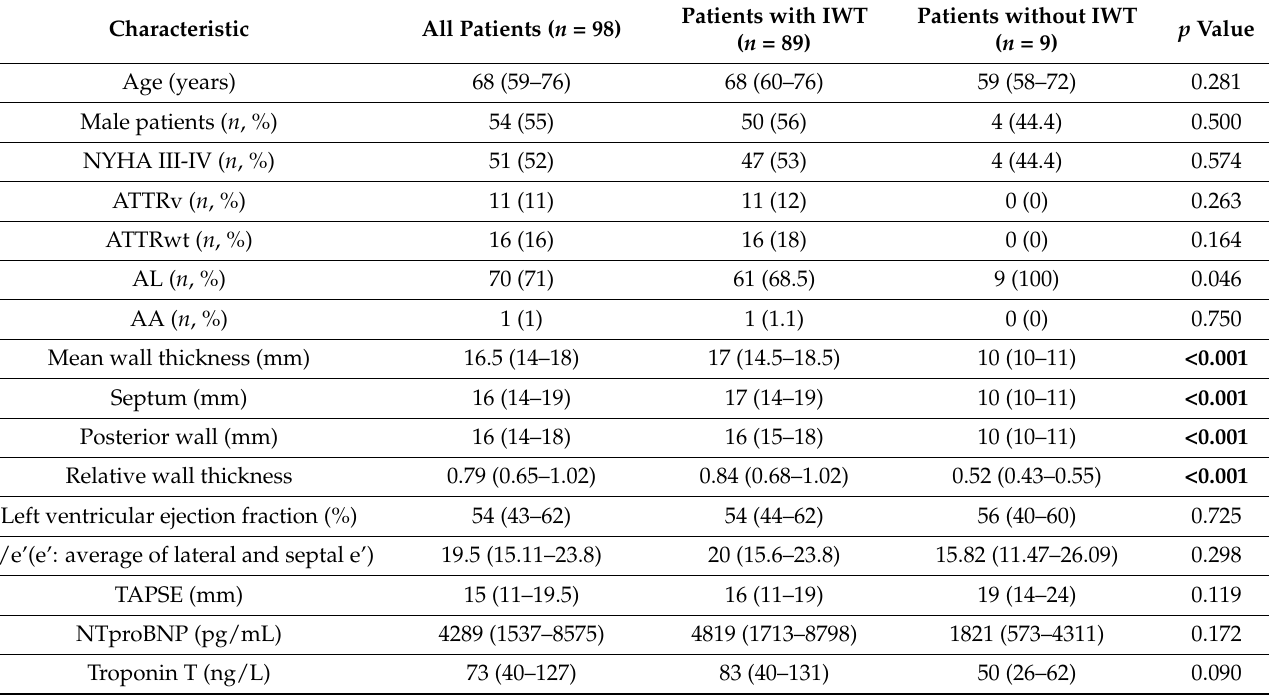
Table 1. Clinical characteristics, serum levels of cardiac biomarkers and the main echocardiographic parameters of the cardiac amyloidosis patients, grouped according to the presence or absence of increased wall